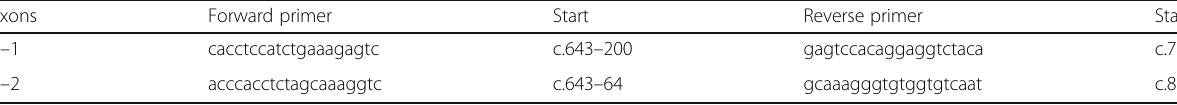
Table 1 Primer sequence for G6PC gene amplification and sequencing